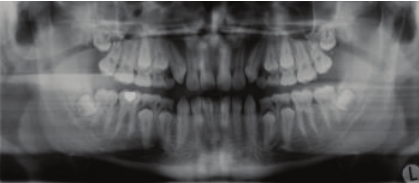
Figure 8: Panoramic radiograph of a 20-year-old male with the Hyper IgE condition. The figure shows deviations in the normal eruption pattern as premolars and two canines have fully formed roots but have not